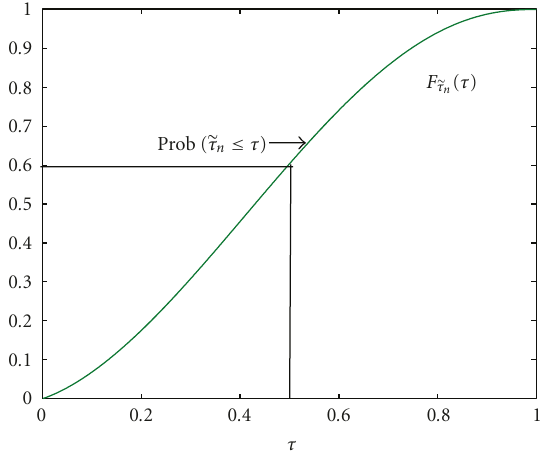
Figure 15: Spatial distribution of (cid:9) τ n in RW.